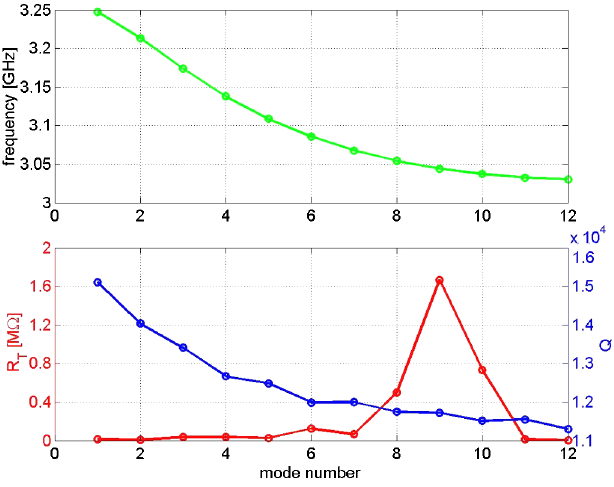
FIG. 5. Resonant frequency, quality factor, and transverse shunt impedance of the vertical trapped modes in the